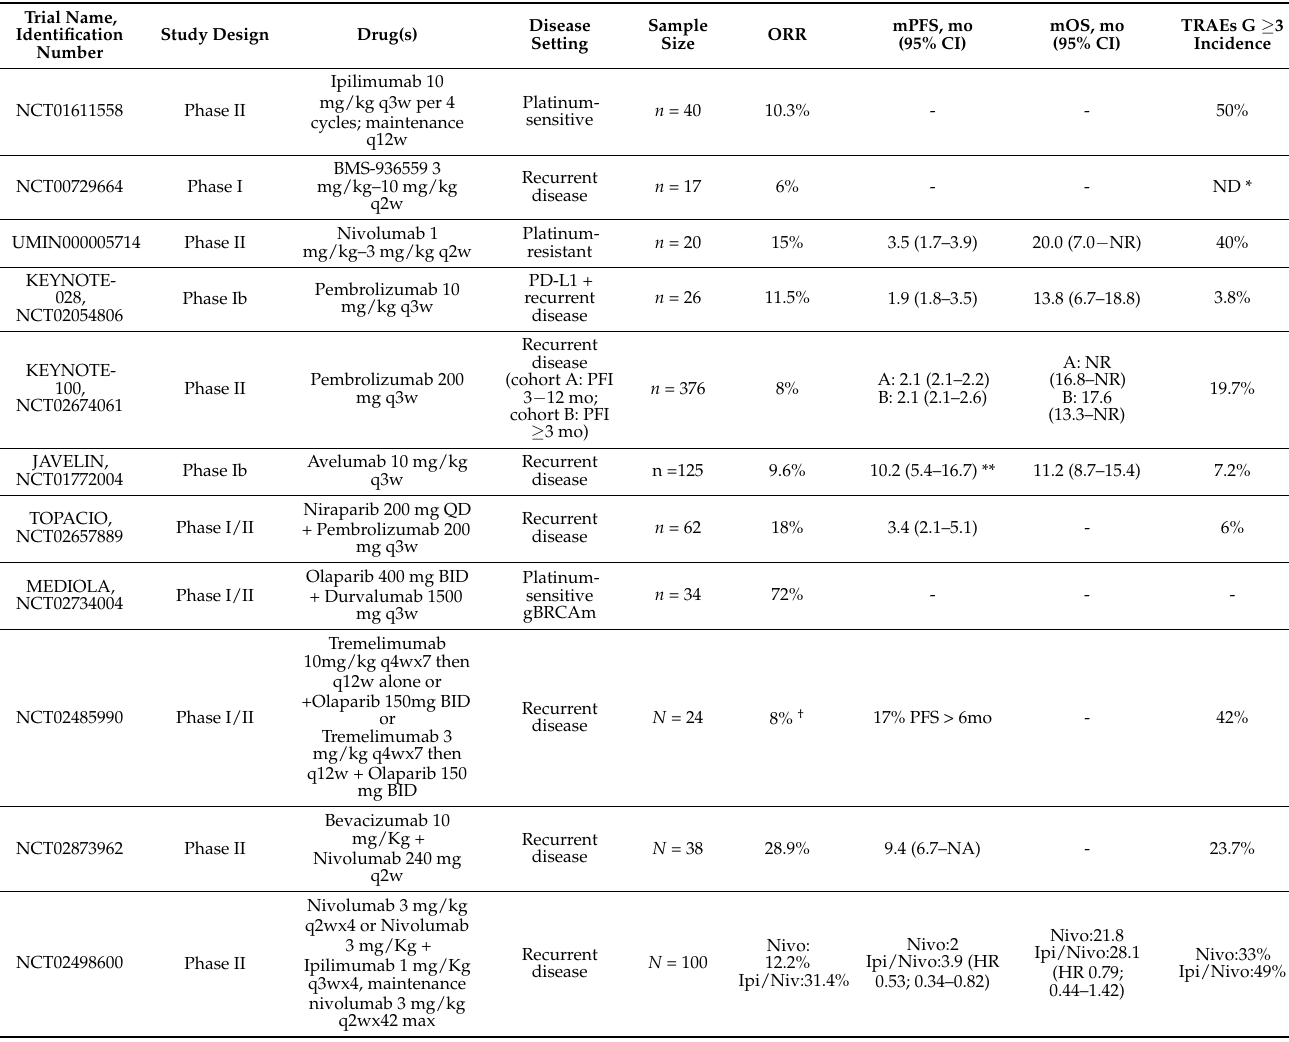
Table 1. Key clinical trials of immunotherapy for recurrent ovarian carcinoma.